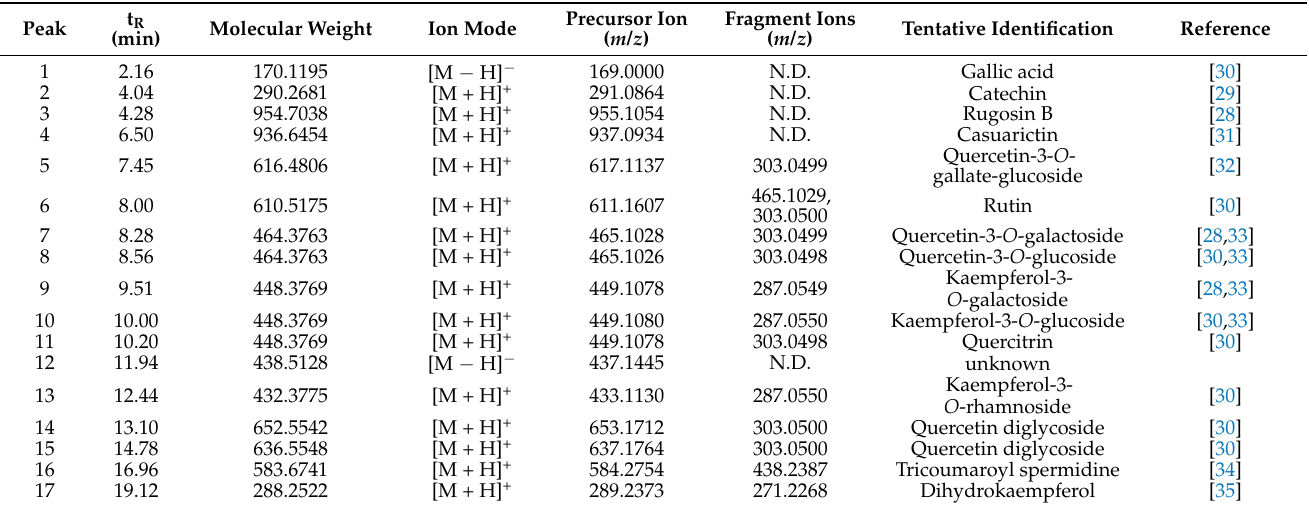
Figure 4. The peak intensity chromatogram of UHPLC − LTQ − Orbitrap/MS/MS of RPE. Peaks are indicated in Table 1. Table 1. Identification of major chemical constituents in RPE by UHPLC − LTQ − Orbitrap/MS/MS. t R Peak